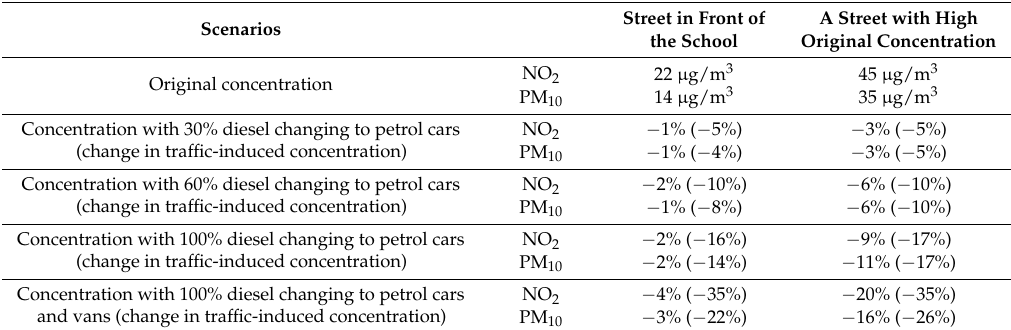
Table 6. The impact of fleet composition changes on the concentration of NO 2 and PM 10 comparison between the street in front of the school (indicated by red dots in Figure 6) and a street with high original pollutant concentration (indicated by yellow dots in Figure